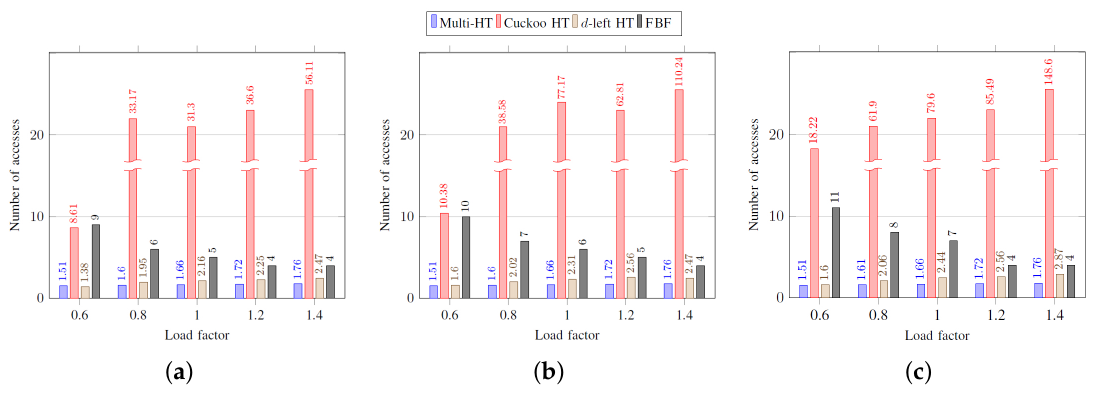
Figure 3. Average number of accesses in inserting an element: ( a ) 8k; ( b ) 32k; ( c )